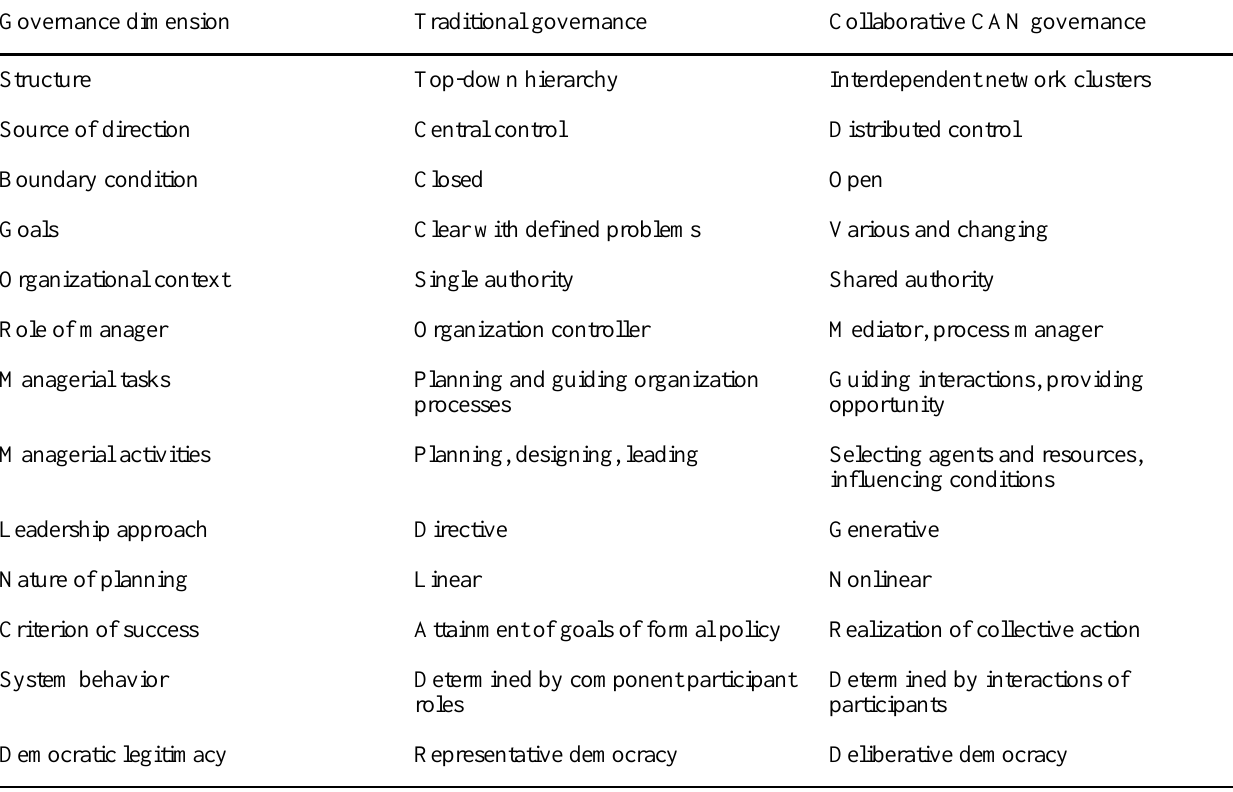
Table 2. Comparing traditional governance and collaborative CAN governance ideas